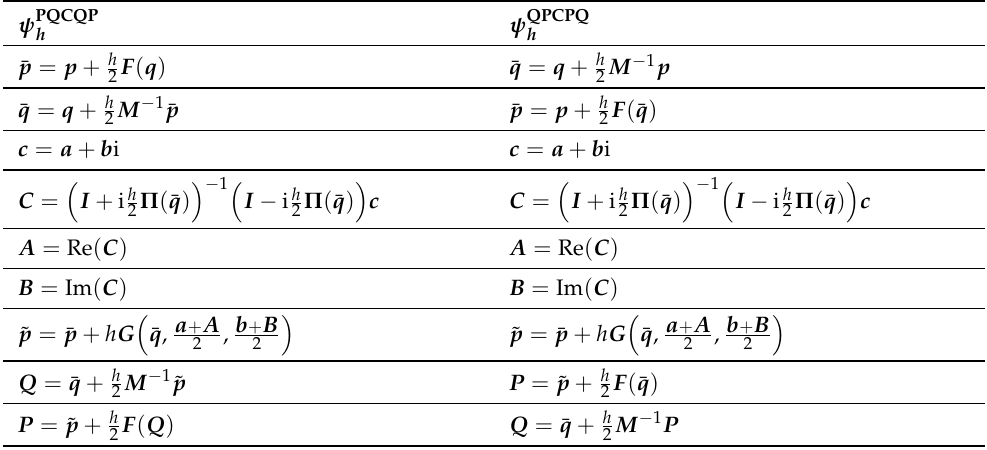
and ψ QPCPQ . h h